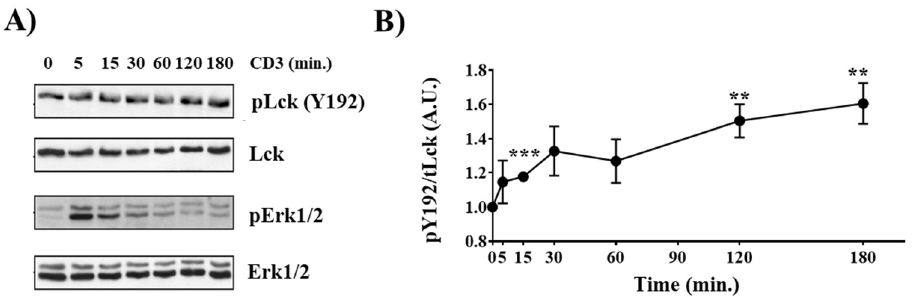
Figure 1. Inducible Y192 phosphorylation upon TCR stimulation in thymocytes. ( A ) Thymocytes were stimulated with immobilized CD3 antibodies for the indicated time points. Subsequently, cell lysates were analyzed for Y192 phosphorylation using a phospho-specific antibody. Successful stimulation was monitored using a phospho-Erk1/2 antibody. Immunoblotting using total Lck and Erk1/2 antibody was used to show equal loading. ( B ) The graph depicts densiometric analysis of the Y192 phospho-signal normalized to that of total Lck. Dots represent mean values ± SEM of three independent mice. Statistical analyses were conducted using an unpaired Student’s t test (** p ≤ 0.01, *** p ≤ 0.001; where not indicated, the values were not statistically significant).